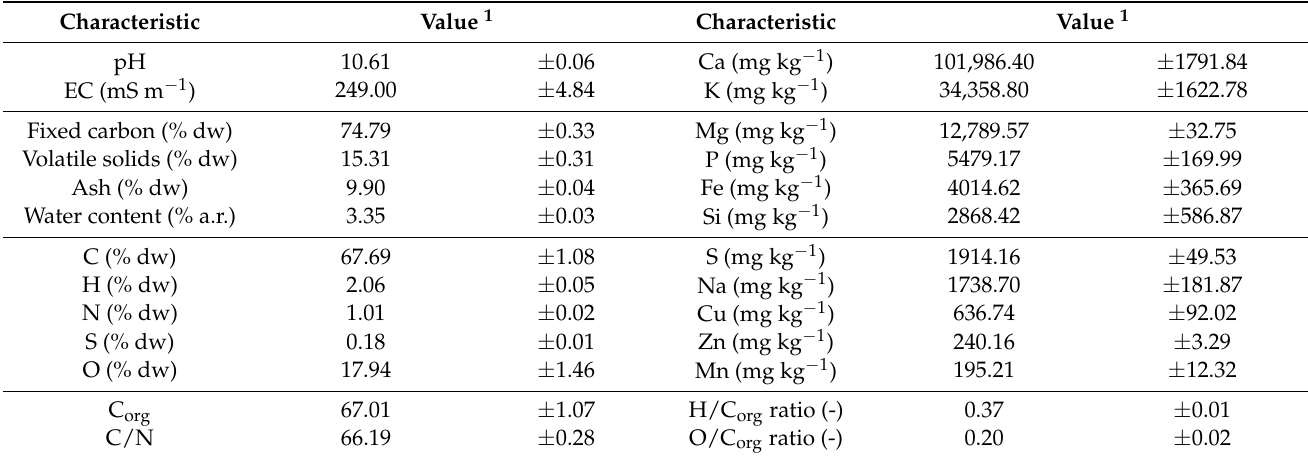
Table 2. Main physicochemical characteristics of biochar added to the